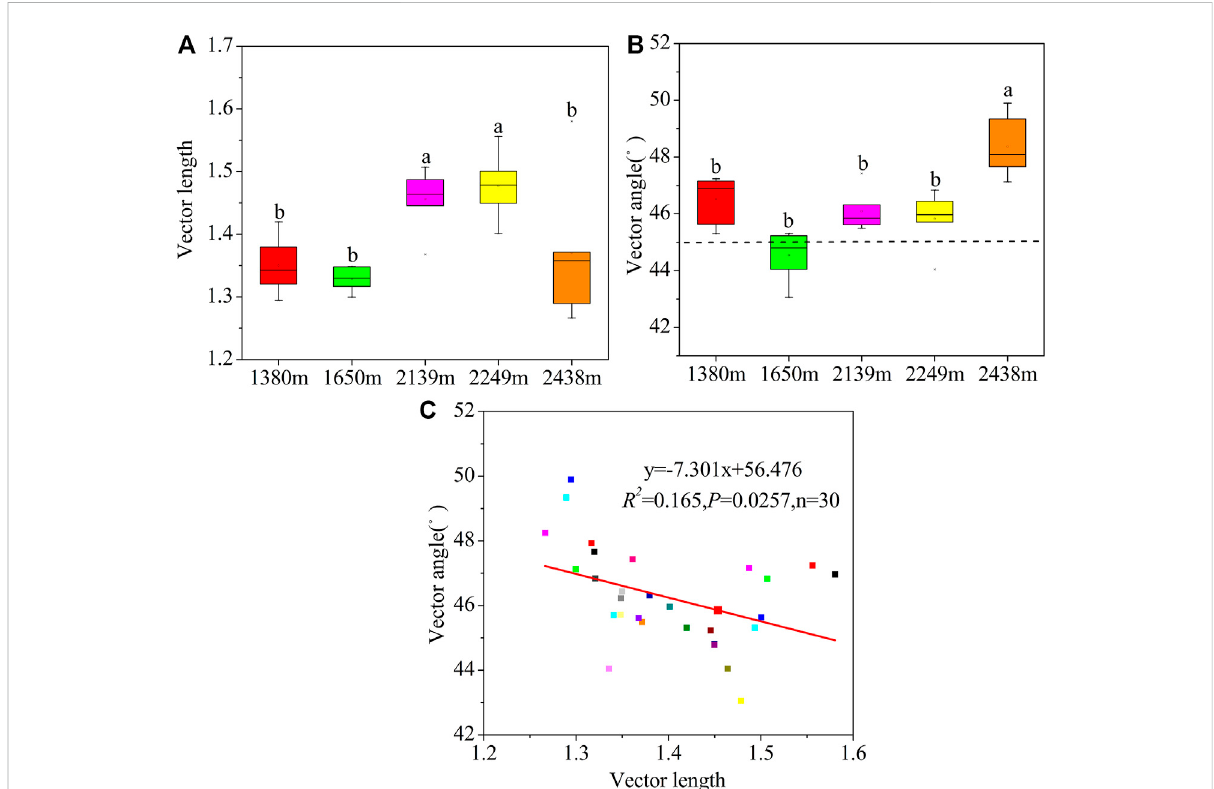
FIGURE 5 Variations in vector length (A) , angles (B) , and the relationship between vector length and angles (C) at the different altitudes. Vector length is representedbysoilmicrobialC limitation,and microbial Climitation increases asthevalues increase.Vector anglesarerepresented bysoilmicrobial N/P limitation, angles > 45 ° represent P limitation, and angles < 45 ° represent N